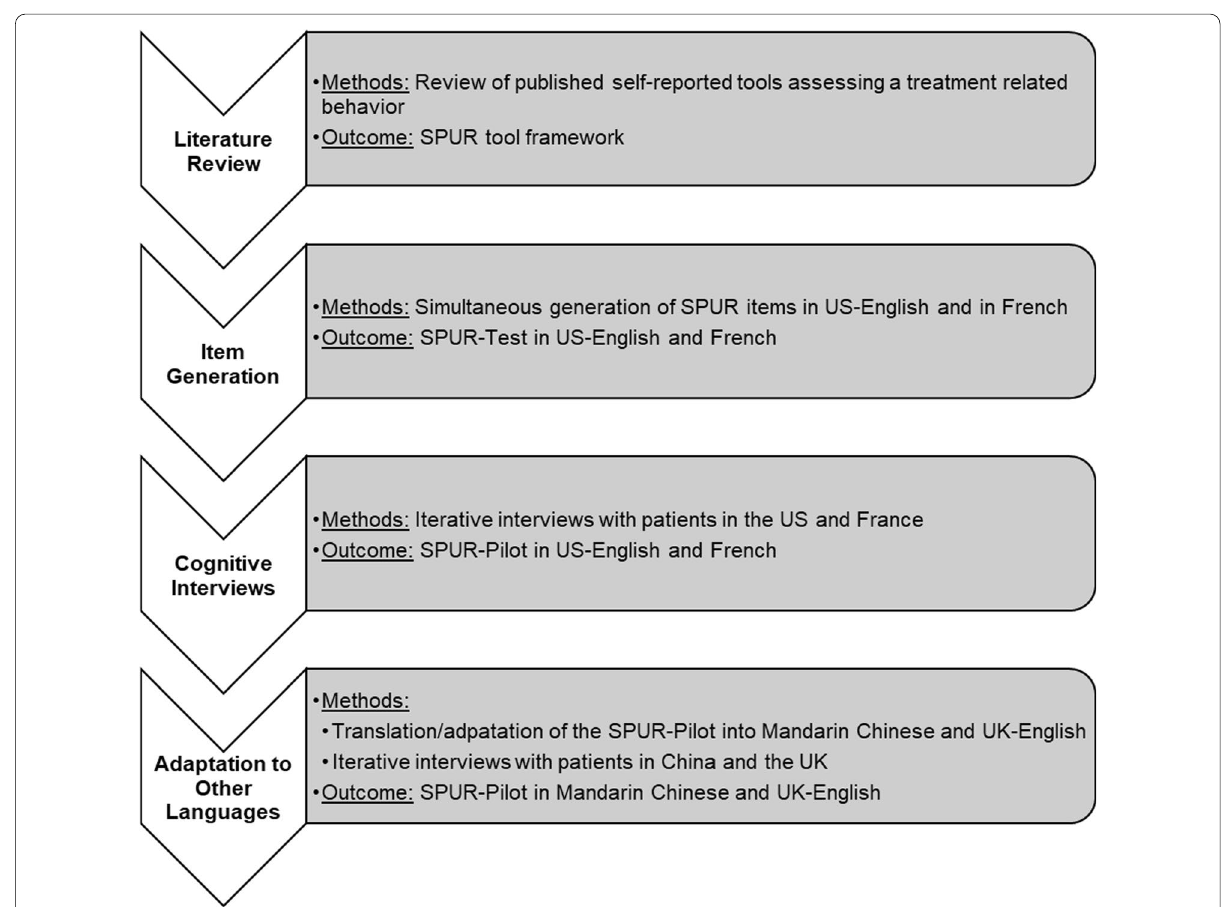
Fig. 1 Development steps of the SPUR tool. SPUR Social, Psychological, Usage,